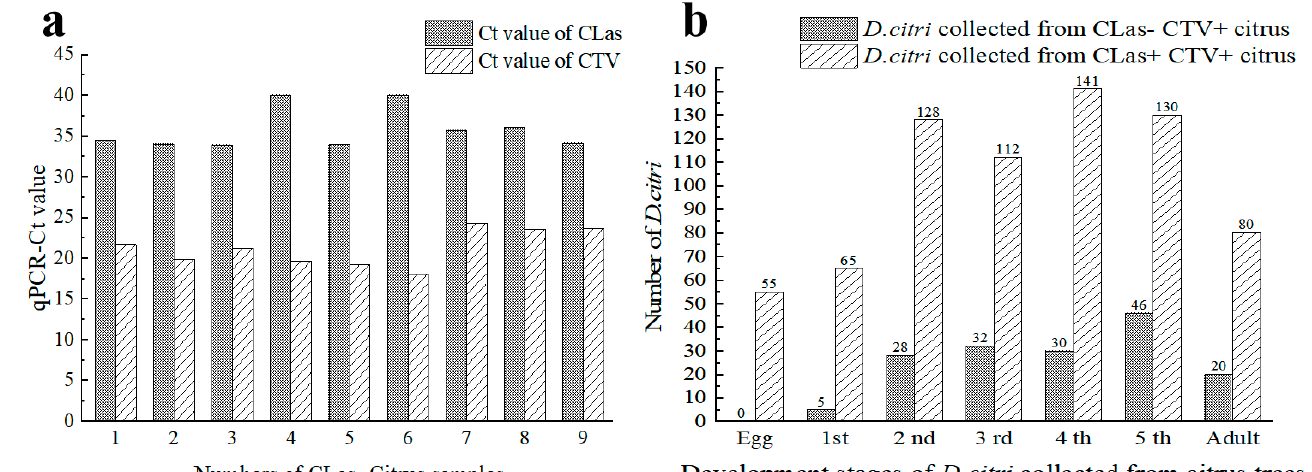
Figure 1. Detection results of ‘ Candidatus Liberibacter asiaticus’ (CLas) and Citrus tristeza virus (CTV) in the D . citri samples from the trees in citrus orchards. ( a ) Detection results of CLas and CTV in branches of the nine citrus trees without HLB; ( b ) The number of D . citri carrying CLas or CTV at each developmental stage. CTV+: CTV positive; CLas+: CLas positive; CLas − : CLas negative. 1st, 2nd, 3rd, 4th, 5th indicate 1st instar, 2nd instar, 3rd instar, 4th instar, and 5th instar, respectively.